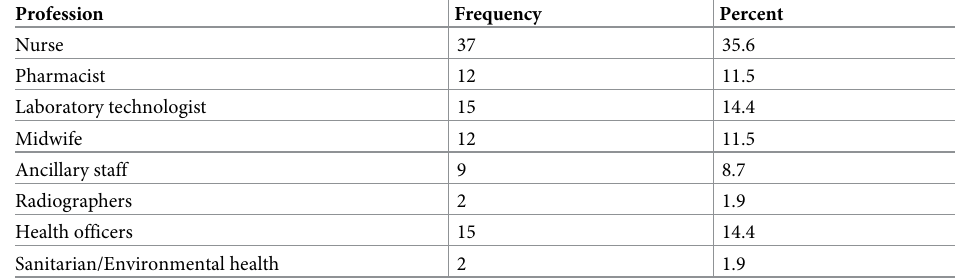
Table 6. Number of managers profession participated in the study healthcare facilities, Addis Ababa City Admin- istration, February 2018.